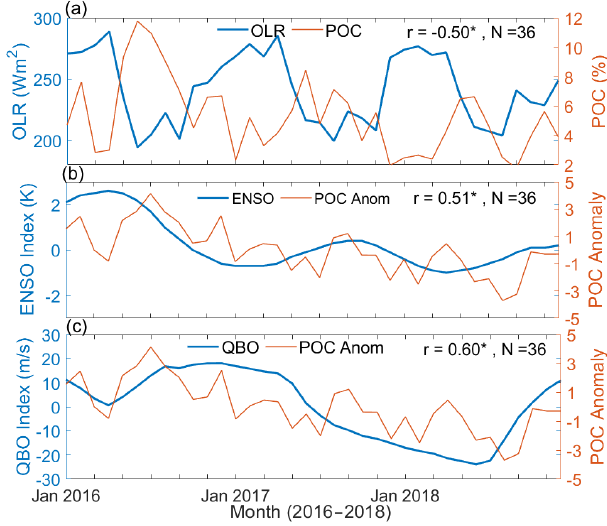
Figure 9. The time series of (a) the POC and OLR, (b) a 4-month lagged ENSO index (the Niño 3.4SST anomalies) and POC anoma- lies, and (c) the QBO indices (the zonal wind at 50hPa) and POC anomalies. The correlation coefficient ( r ) and the number of months ( N ) are also shown. An asterisk indicates that the correlation coef- ficient is significant at 95% confidence